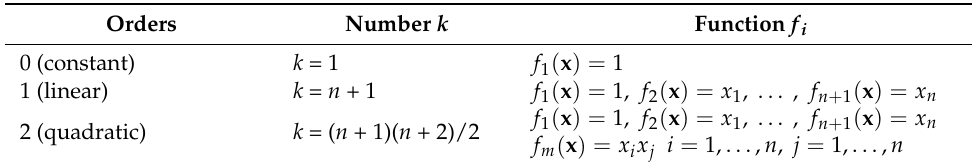
Table 1. Regression